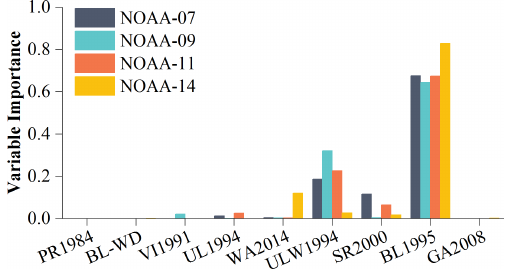
Figure 5. Importance of the nine SWAs for the RF ensemble